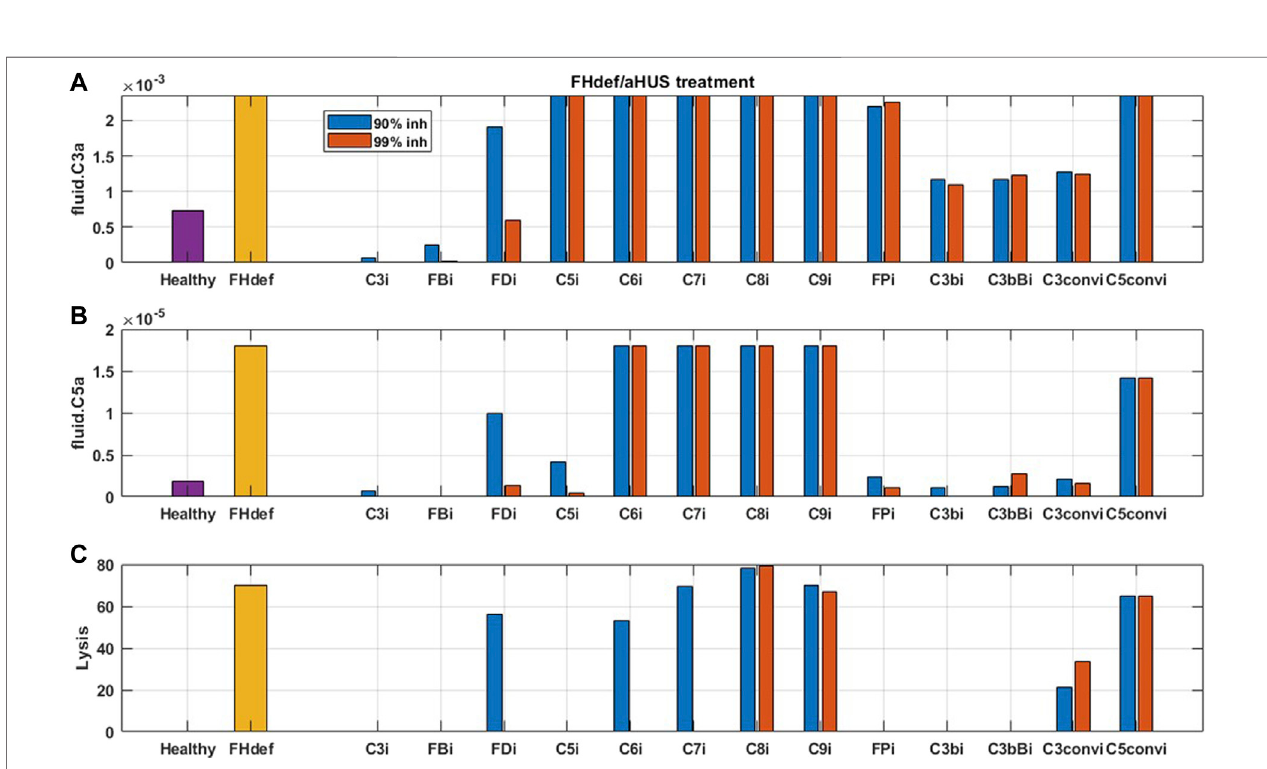
FIGURE 10 | Model predictions for the effect of 90 and 99% inhibition of complement proteins (C3, FB, FD, C5, C6, C7, C8, C9, FP, C3b, C3bB, C3-convertase (C3conv), and C5-convertase (C5conv)) on complement activation driven by 40% FH de fi ciency such as in aHUS.